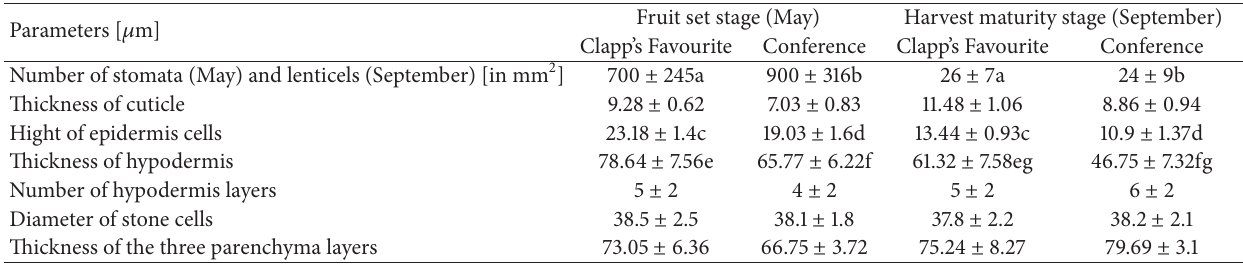
Table 1: Characteristics of “Clapp’s Favourite” and “Conference”